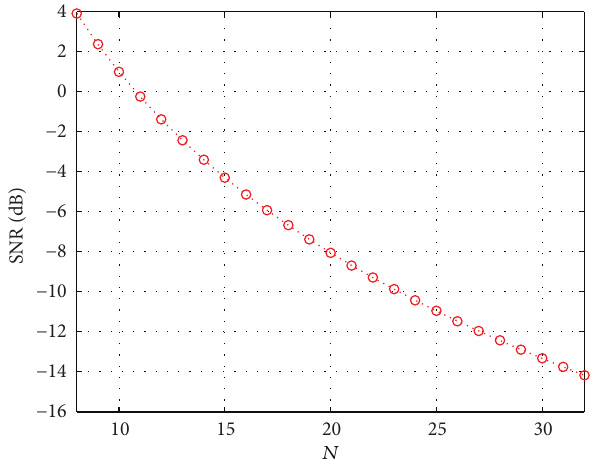
Figure 4: The accumulated pulse number versus the resolution threshold.